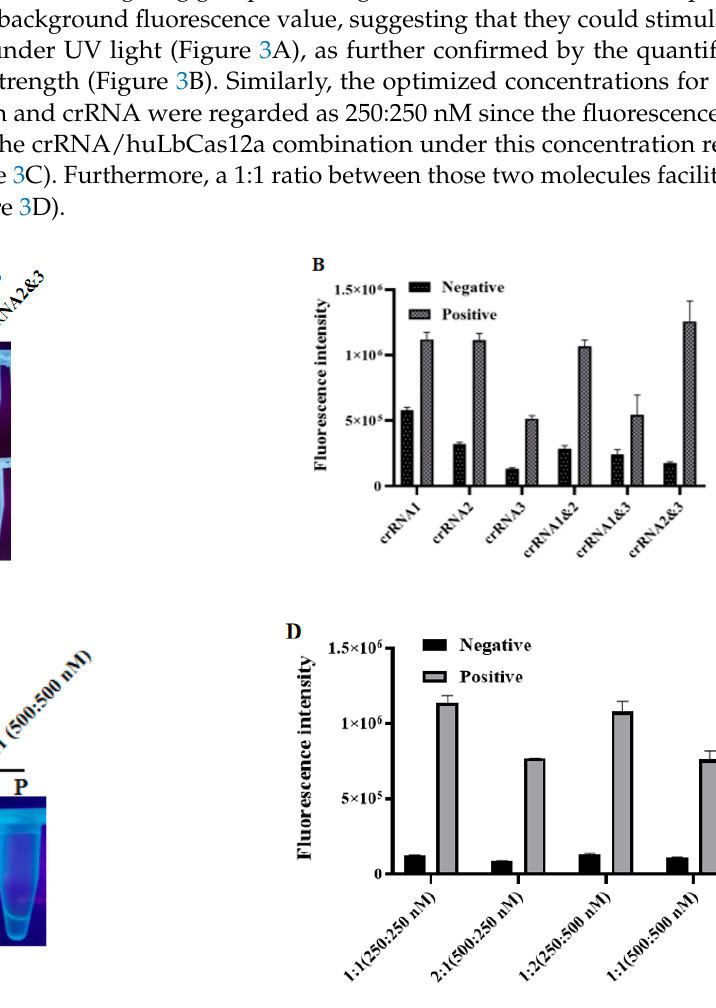
Figure 3. Fluorescence-based optimizations for the CRISPR assay. Different crRNA/huLbCas12a combinations were allowed to cleave target DNA for 30 min. ( A ) Visual results of crRNA screening under UV light. ( B ) Histogram of fluorescence values measured by ABI QuantStudio 5. ( C , D ) The optimal ratio of huLbCas12a to crRNA ( n = 3 technical replicates, value represents mean ± SEM).